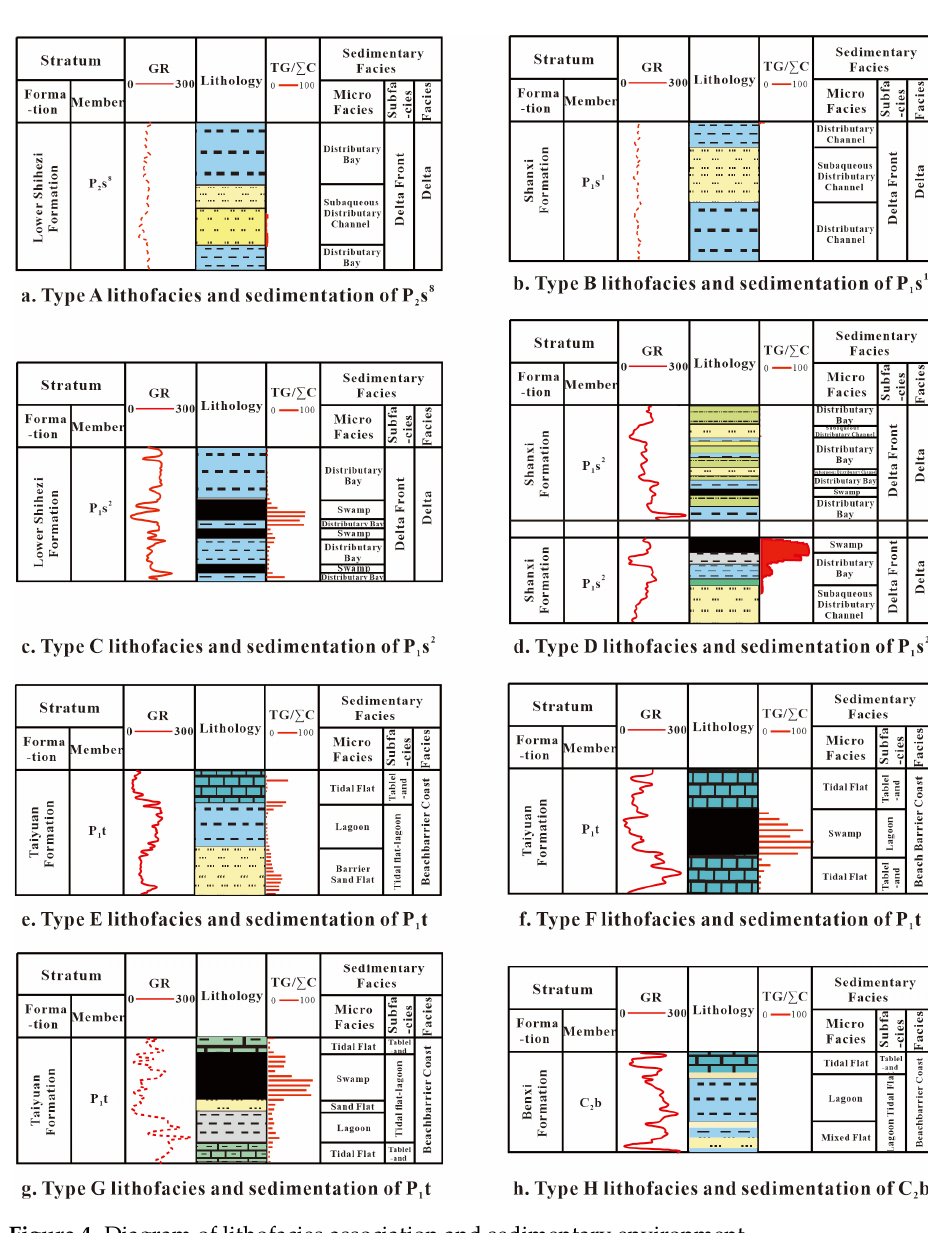
Figure 4. Diagram of lithofacies association and sedimentary environment.